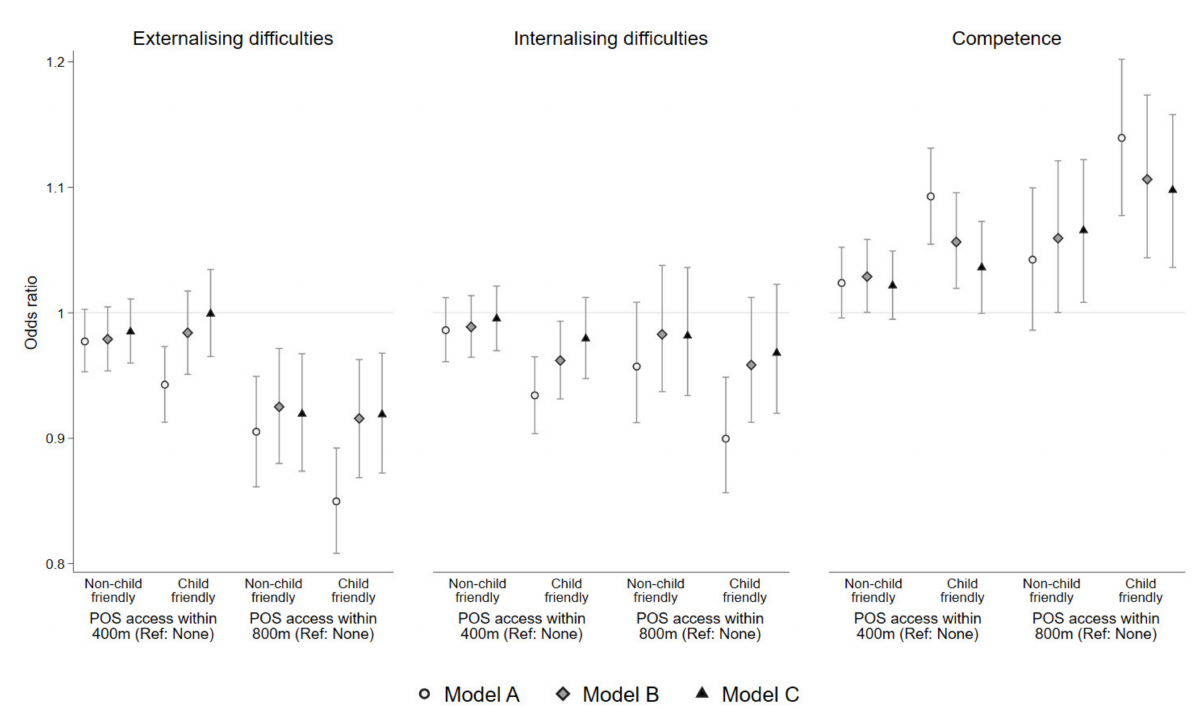
Figure 3. Unadjusted (Model A) and adjusted (Models B and C) associations (odds ratios and 95% credible intervals) between public open space exposures and children’s odds of demonstrating externalising difficulties, internalising difficulties, and high competence. Model A: unadjusted associations. Model B: adjusted for child’s sex, language background, and English proficiency, Aboriginal and Torres Strait Islander background, additional health and education needs, and maternal education. Model C: adjusted for child- and family-level demographics (Model B) plus neighbourhood disadvantage. For all models, the reference category for public open space exposures was the no access (none)